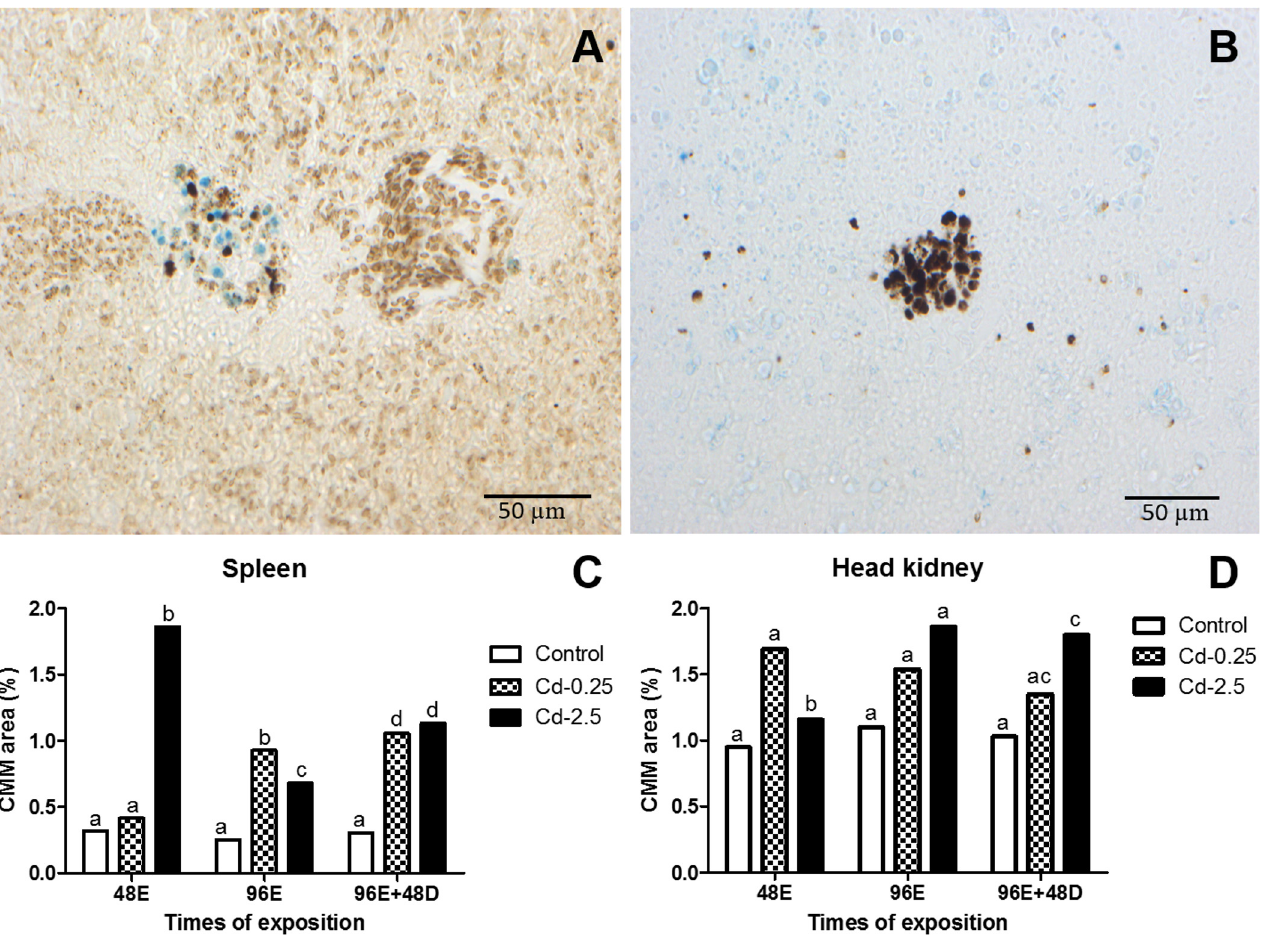
Fig 9. Melanomacrophage centres in spleen and head kidney of O . niloticus stained by Pearls ’ histochemical technique. (A, B) MMC exhibiting lipofuscin (yellow-brownish) and melanin (black) pigments. (C, D) Percentage of the volumetric data melanomacrophage centres in tilapia submitted to different treatments. Values followed by different letters differ by Fisher test (p <